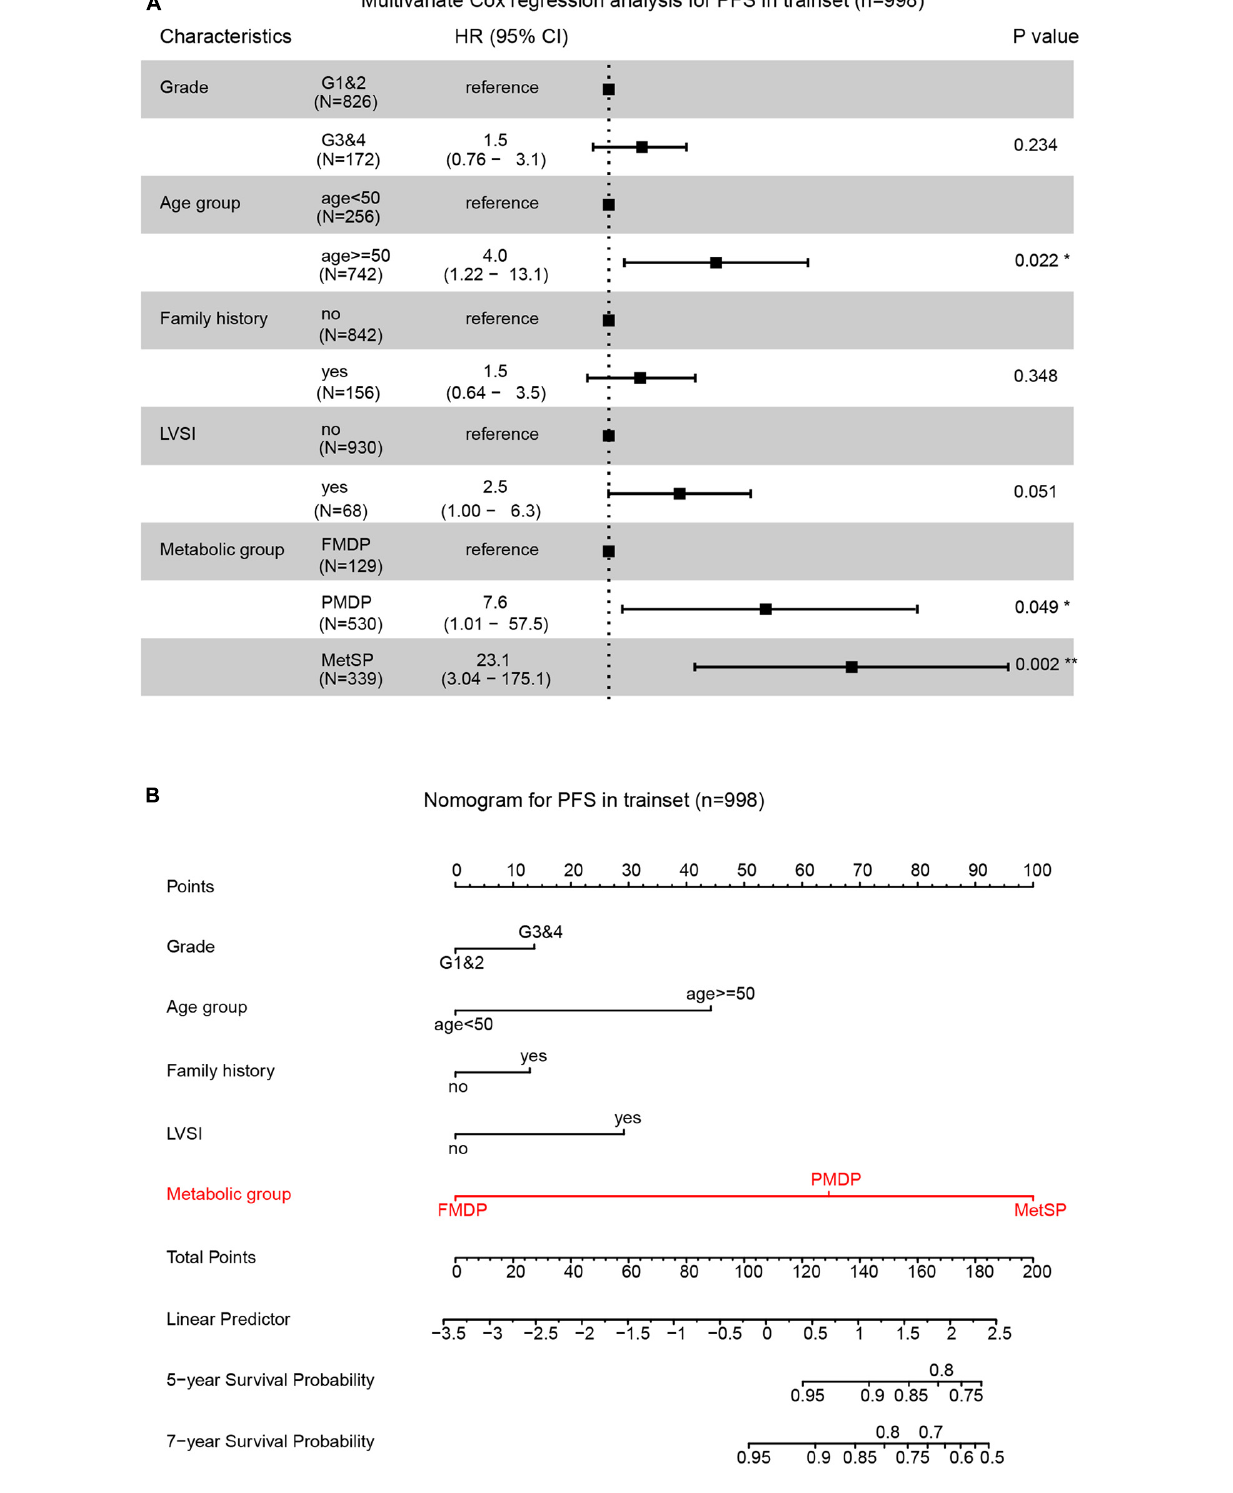
Frontiers in Medicine |